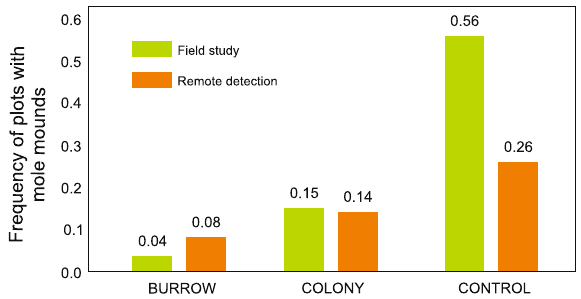
Figure 7. Frequency of plots with mole mounds assessed in the field study and by remote sensing. The clear avoidance of sousliks and moles near the souslik burrows and home range of the souslik colony was shown by both methods, but the remote methods indicated a lower level of occurrence of the mole in the control plots. All differences between the zones were statistically significant (p < 0.05) in the pairwise comparison of the frequency of the mole mounds in the field study. In the case of the remote detection, there were statistically significant differences in the BURROW-CONTROL and COLONY-CONTROL pairs (p < 0.05). The figure was generated in SPSS v24.0 (https:// www. ibm. com/ produ cts/ spss- stati stics) and CorelDRAW Standard 2020 (https:// www. corel.